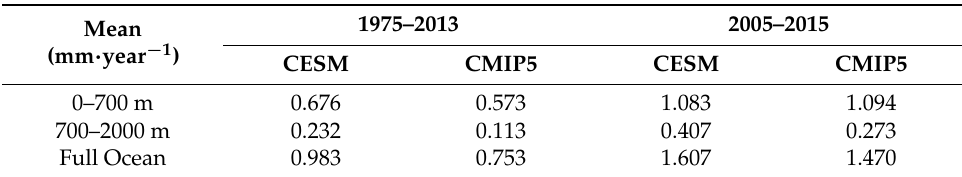
Table 2. Ensemble mean trends in steric sea-level rise for both periods and ensembles over all evaluated depths.